Question: Briefly state, in one sentence, what is plotted here.
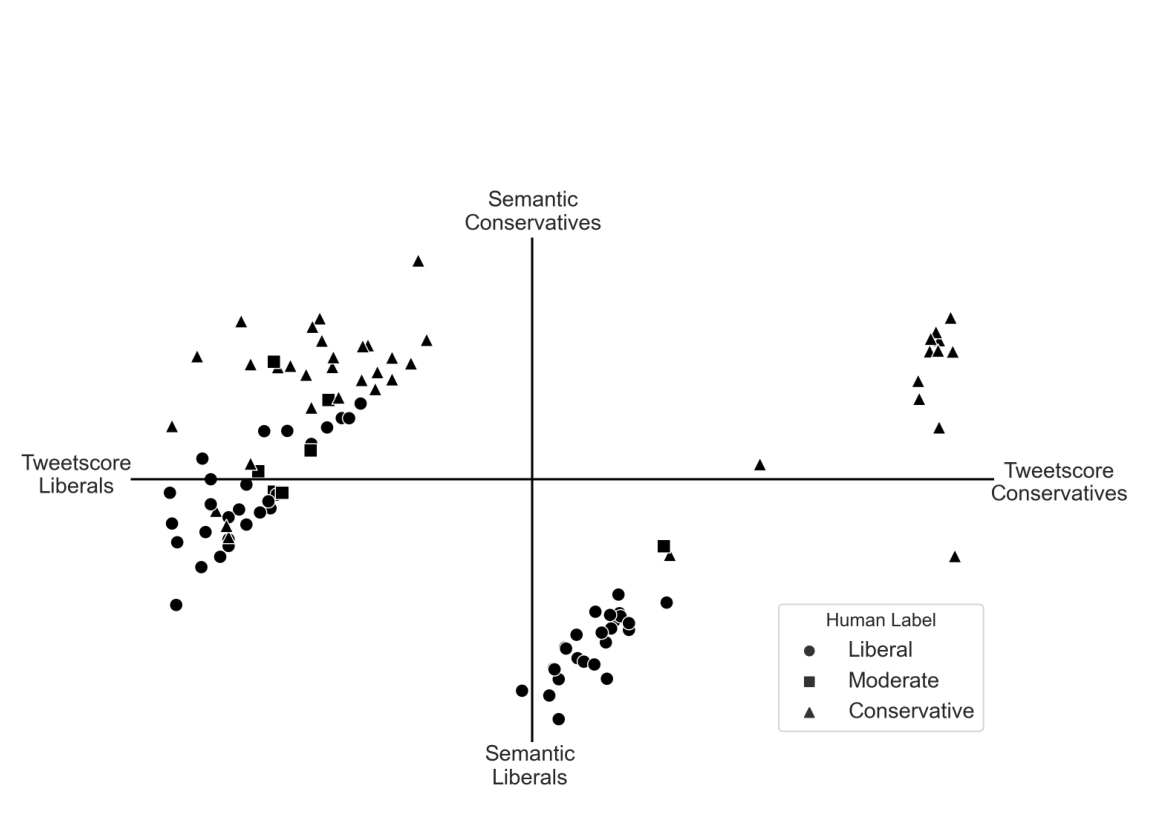
Answer: Scatter plot of the 100 observations with the highest residuals when regressing Tweetscores on Semantic Scaling. Axes are drawn at the local minimum between the modes of the distributions to roughly divide liberals and conservatives. Human labels derived by reading a random sample of tweets from each user largely agree with Semantic Scaling over Tweetscores.